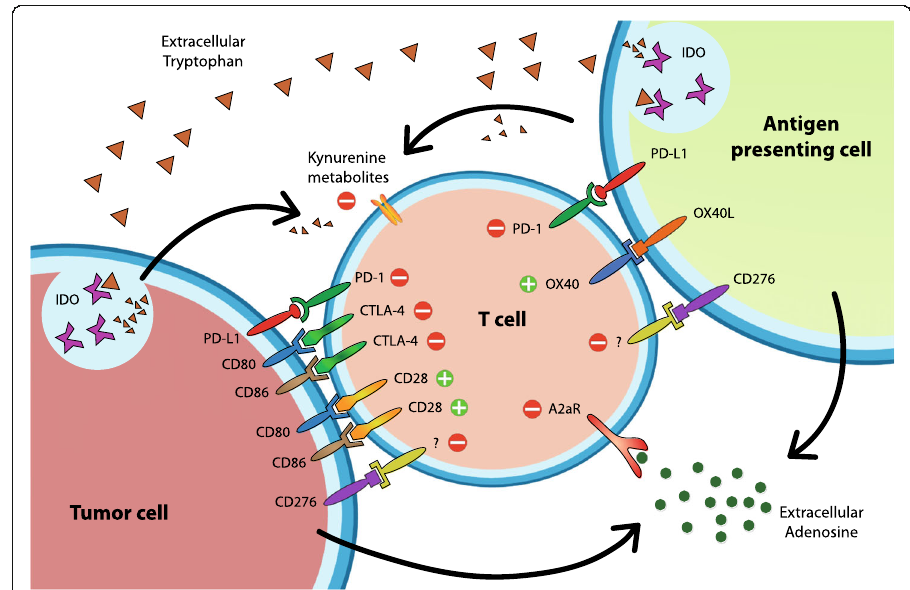
Fig. 1 Immune checkpoint expression and main interactions on cell types which predominantly express them. Depicted are immune checkpoints for which tracers have been developed. Not all immune checkpoint interactions are known nor are all interactions displayed. For further reading on immune checkpoints, we refer to De Sousa Linhares et al. (2018) PD-L1: Programmed Death-ligand 1,